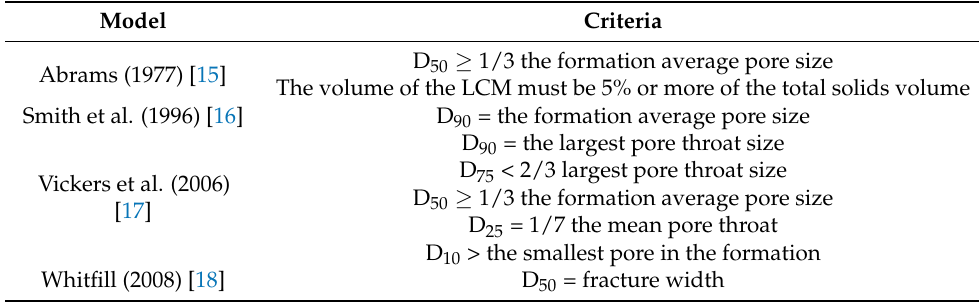
Table 1. Current LCM particle size selection guidelines for plugging